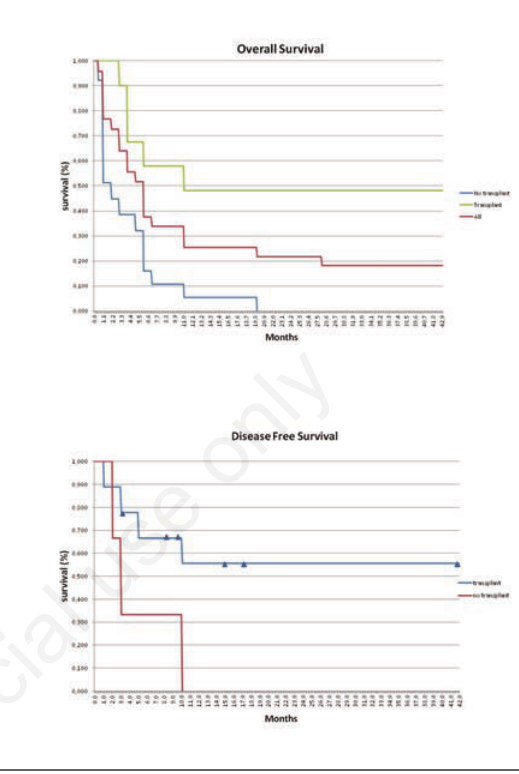
Figure 1. Overall survival and disease free survival on 25 patients treated with clofarabine and cytarabine.